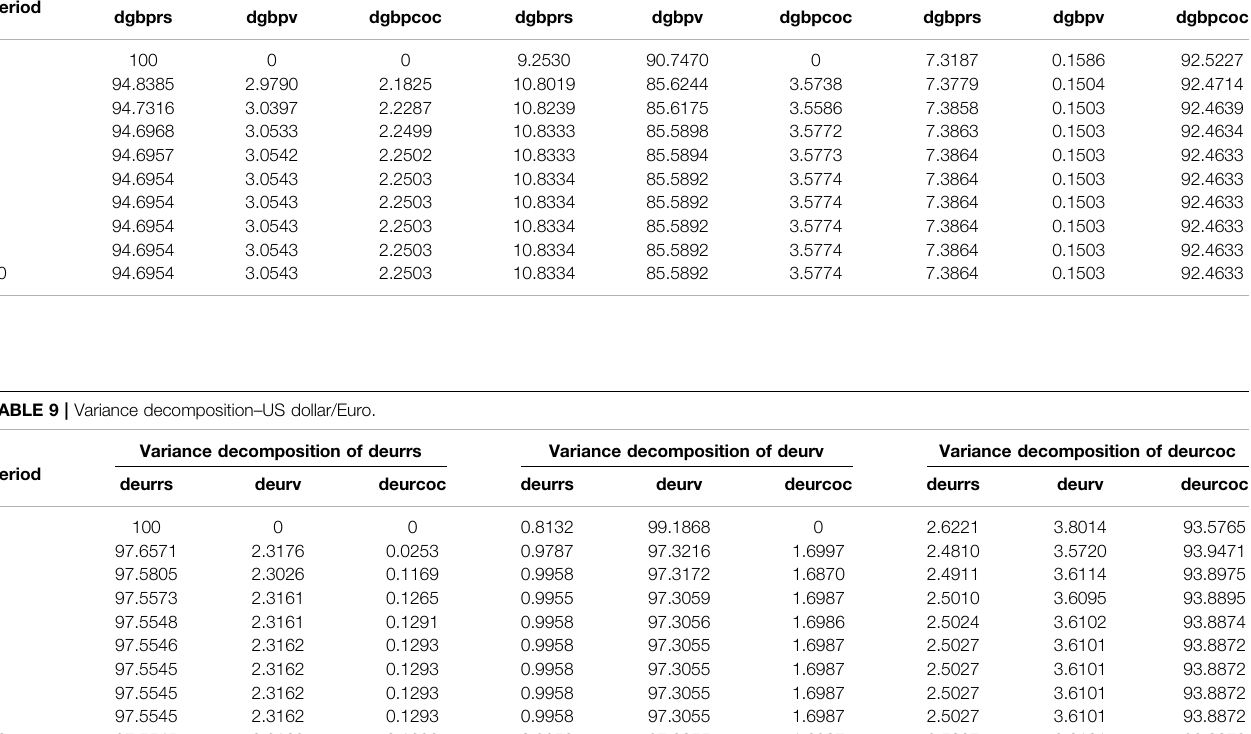
TABLE 8 | Variance decomposition – US dollar/UK pound. Variance decomposition of dgbprs